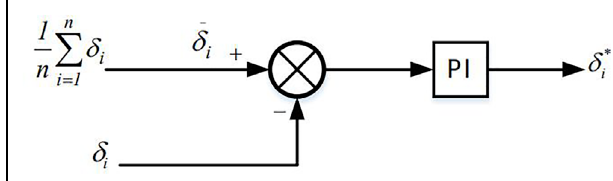
FIGURE 4 | Block diagram of power angle balance